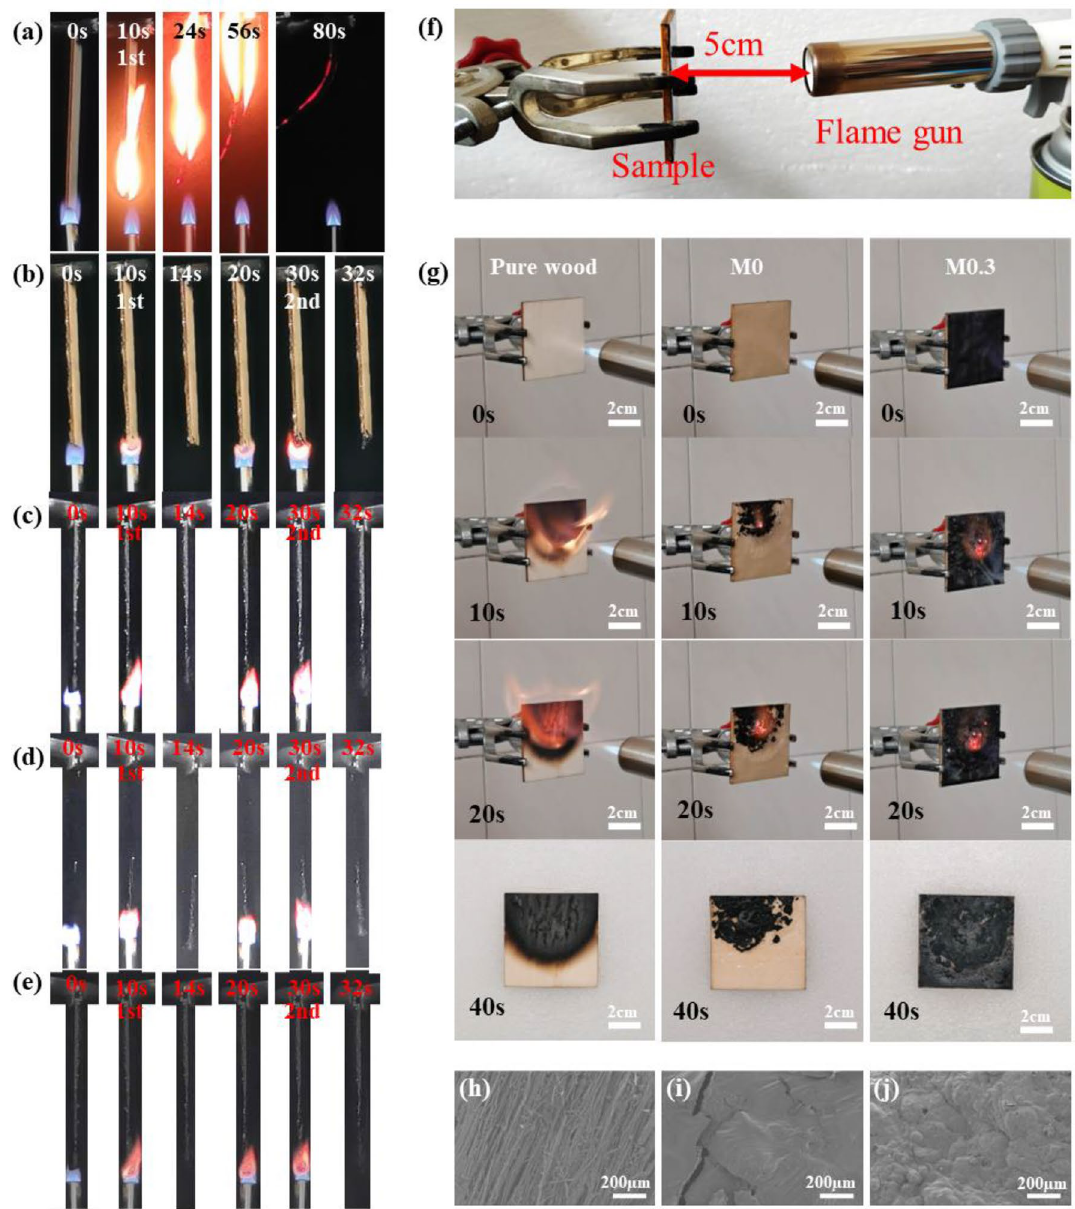
( g ) The photos of pure wood and M-hydrogel-coated wood in open fire test. ( h ) The SEM images of char layer of ( h ) pure wood, ( i ) M0, and ( j ) M0.3 hydrogel-coated wood after open fire